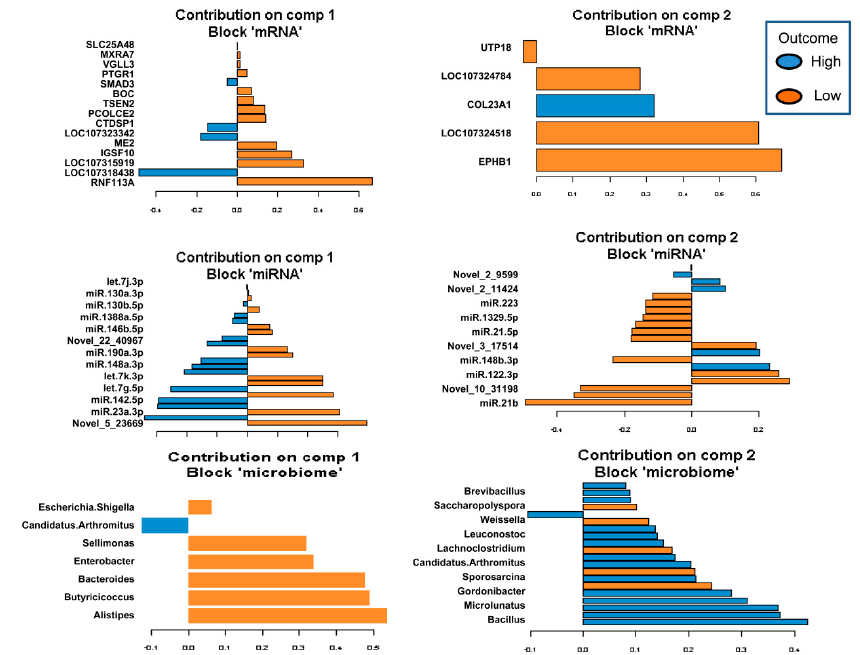
Figure 5. The optimal omics biomarker set of host mRNA, miRNA and microbial genera which correlated with the phosphorus utilization (PU) groups low and high over 2 component sets. The minimal set of features selected by DIABLO across data types could discriminate between high and low PU groups in DIABLO Components 1 and 2. Blue indicates a high PU group and orange indicates a low PU group. (DIABLO: Data Integration Analysis for Biomarker discovery using Latent cOmponents).